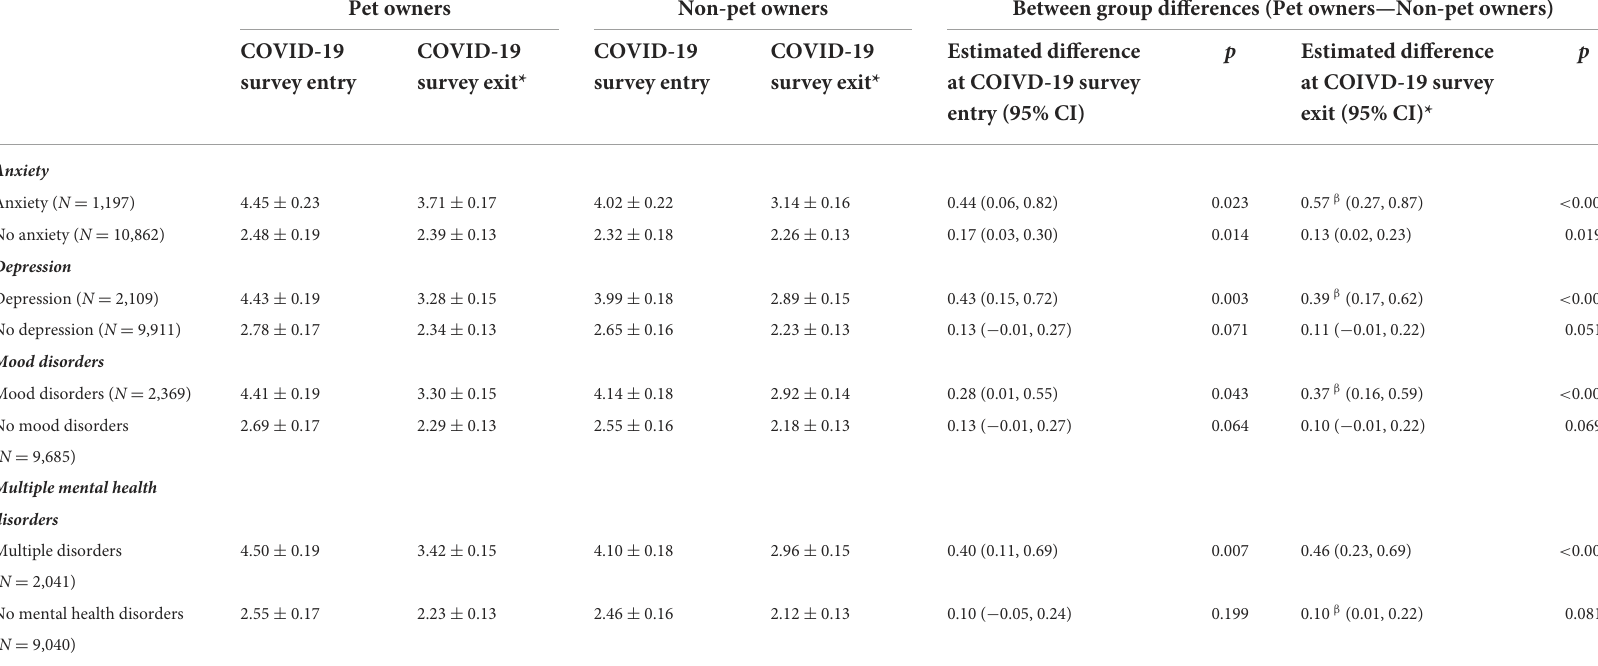
TABLE 5 Estimated marginal means and standard errors for General Anxiety Disorder Questionnaire (GAD-7) score at COVID-19 Survey entry (April 15–May 30, 2020) and exit (September 29–December 29, 2020), based on mental health disorder status and pet